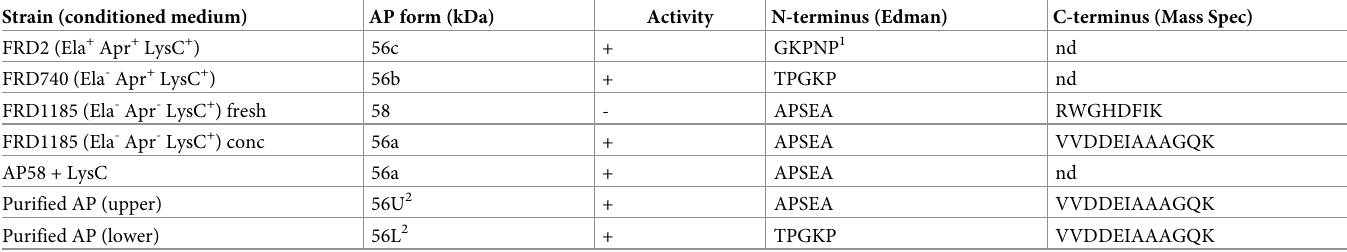
Table 1. N- and C-terminal amino acid sequences found for various forms of